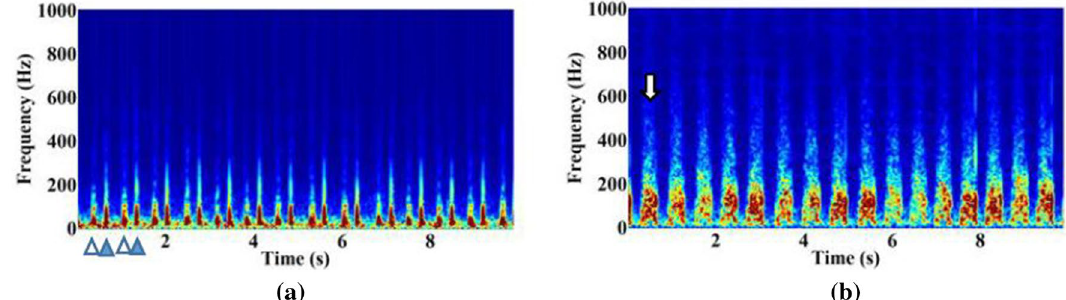
Figure 3. Spectrograms of heart sounds from the normal subjects ( a ) and the subjects with VSD ( b ). The spectrums of sounds or other signals as they vary with time is shown. S1 (empty triangle) and S2 (solid triangle) are observed in the spectrogram of the normal heart sound. Systolic murmur (white arrow) is observed in the spectrogram of the VSD heart sound.